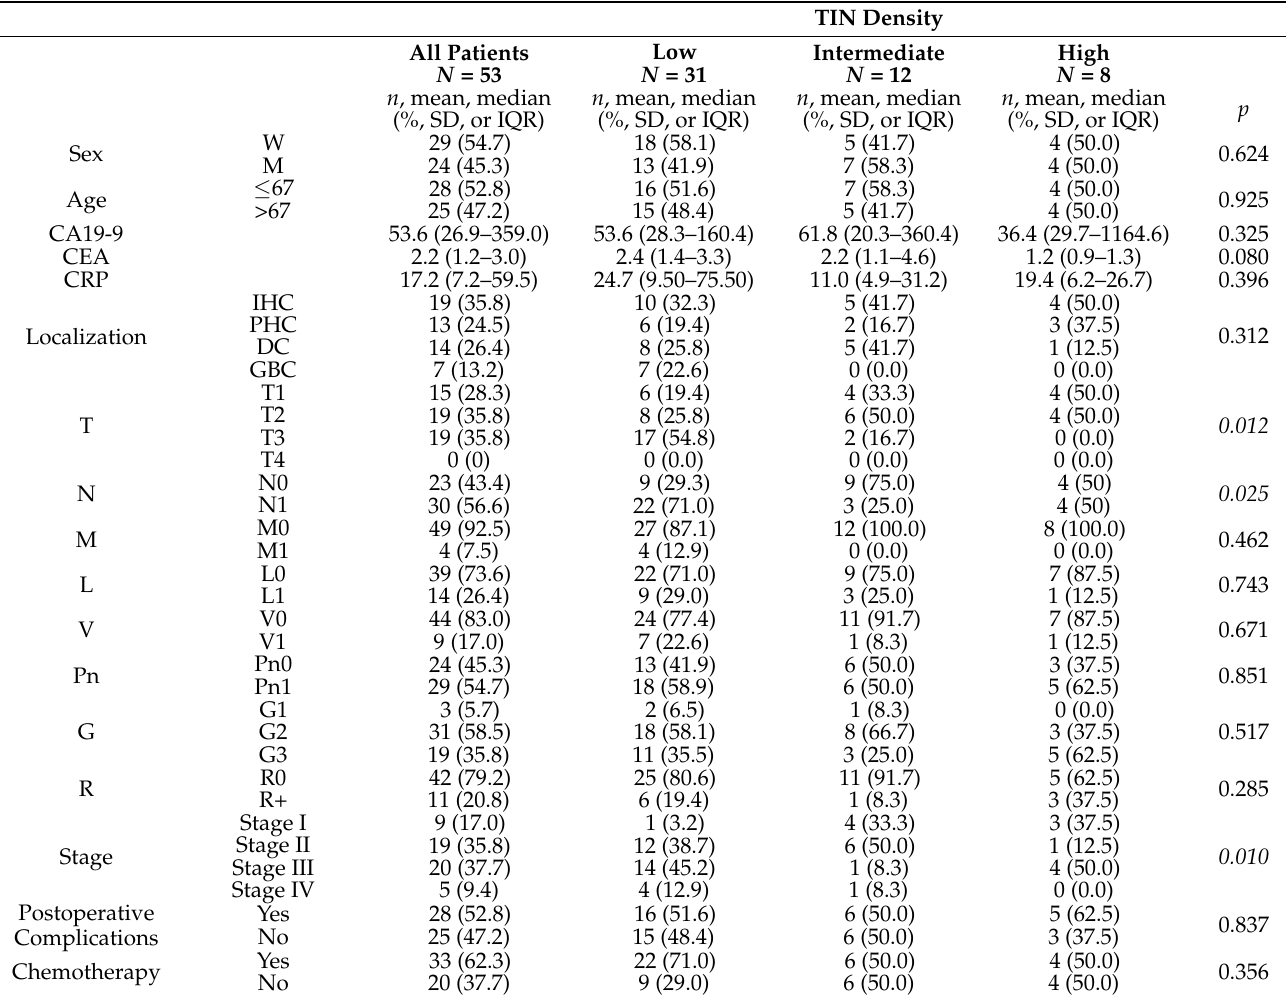
Table 1. Patient’s characteristics according to the extent of tumor-infiltrating neutrophils (TINs) in resected biliary tract cancer